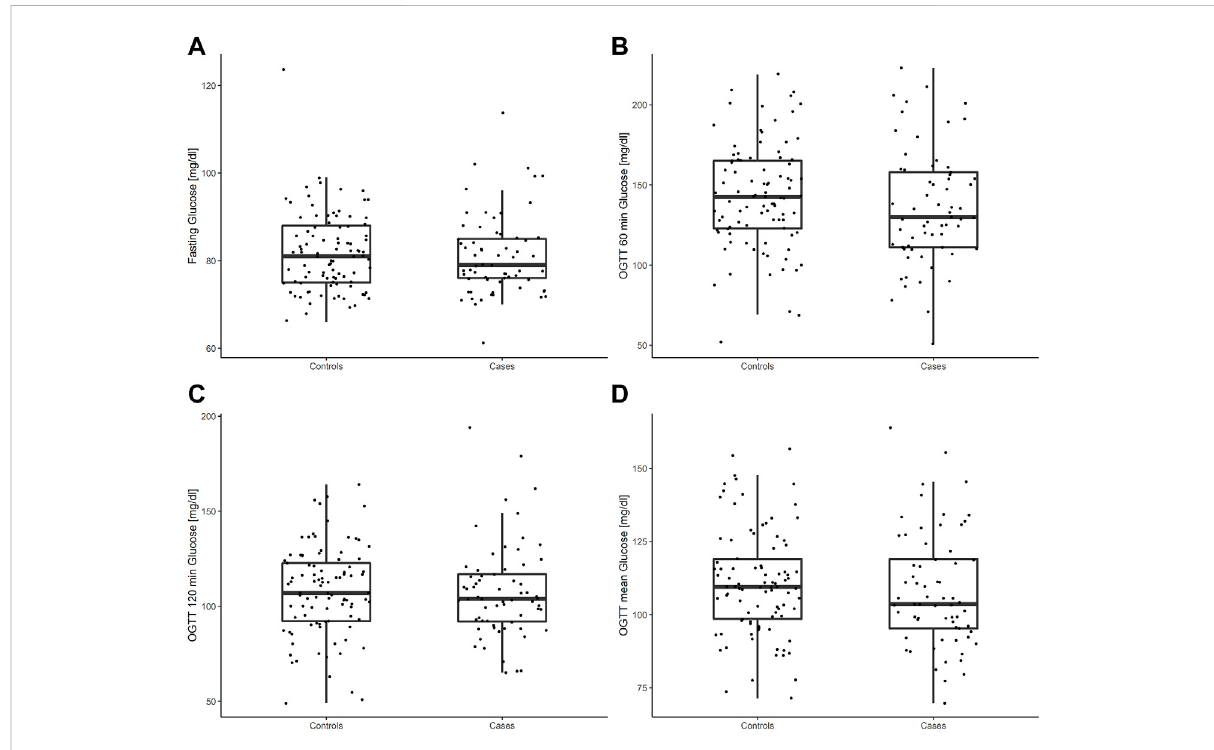
FIGURE 1 Glucose concentrations during thediagnostic 75-g OGTT at24 – 28 weeks of gestation in women with history ofSARS-CoV-2 infection (cases) and the control group without infection (controls): fasting glucose (A) , 60 min post load glucose (B) , 120 min post load glucose (C) , mean glucose (D)